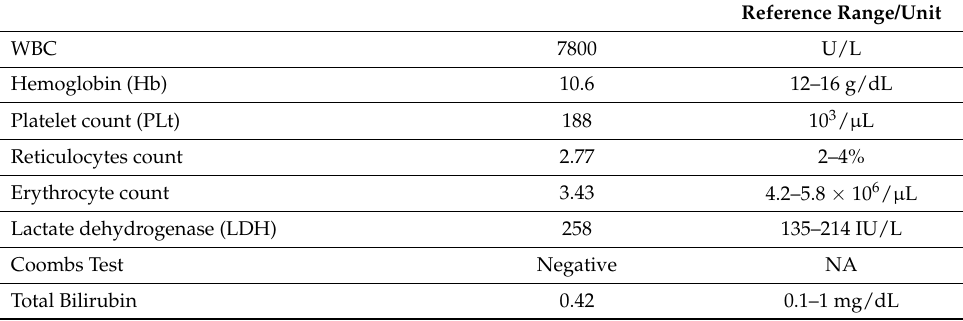
Table 1. Laboratory findings on